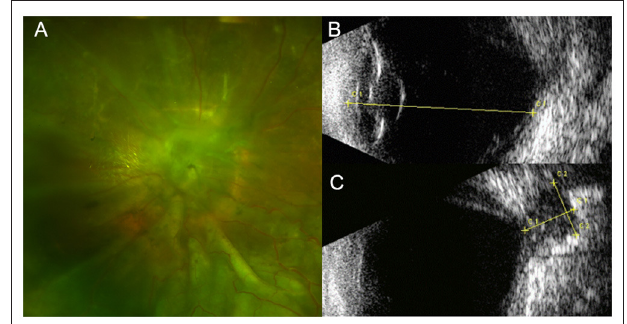
FIGURE 1 | One sample of echographic measurement with digital images. (A) Fundus image of one eye of morning glory disc anomaly (MGDA) with retinal detachment (RD). (B) The axial length (AL) was measured from the anterior apex of cornea to the anterior of retina close to the margin of excavation. (C) The maximal cavitary depth (C1-C1) and the maximal cavitary width (C2-C2) were measured at the maximal cross section of the excavation.